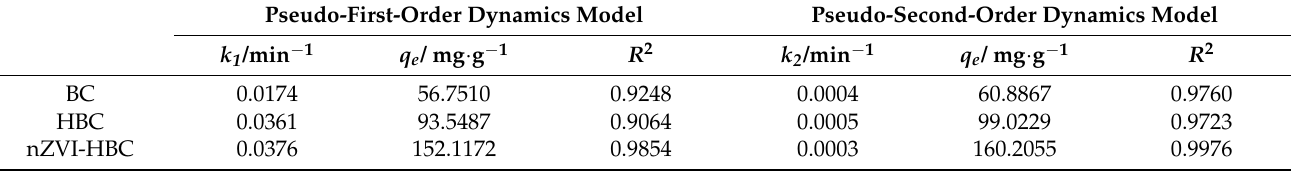
Figure 11. Adsorption kinetics curves of OTC adsorption of BC, HBC, and nZVI-HBC. ( a ) pseudo- first-order and pseudo-second-order dynamics model. ( b ) intra-particle diffusion model. Table 3. Pseudo-first-order and pseudo-second-order dynamics model fitting parameters of OTC adsorption of BC, HBC, and